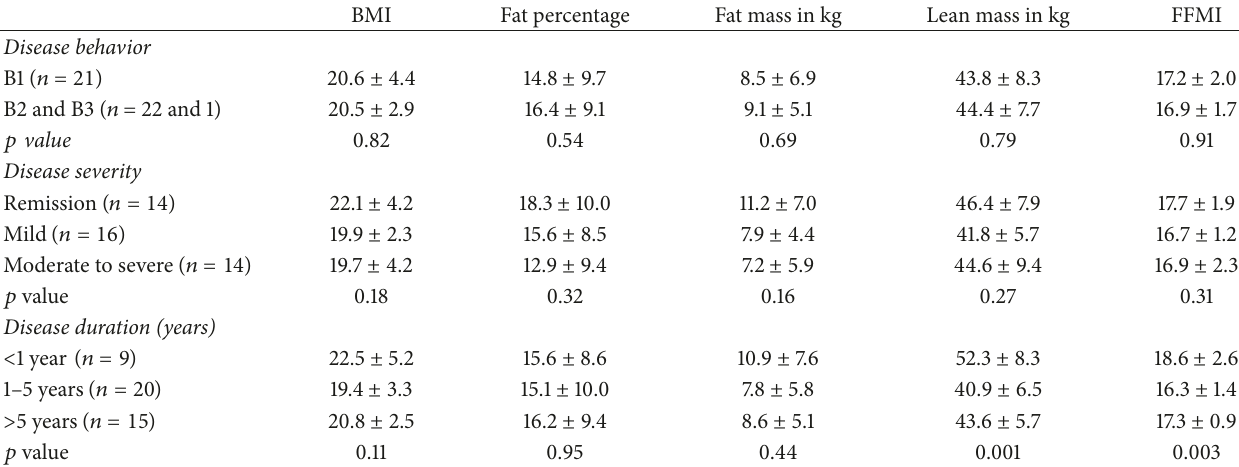
Table 4: Effect of disease behavior, clinical severity, and disease duration on body composition in patients with Crohn’s disease. BMI